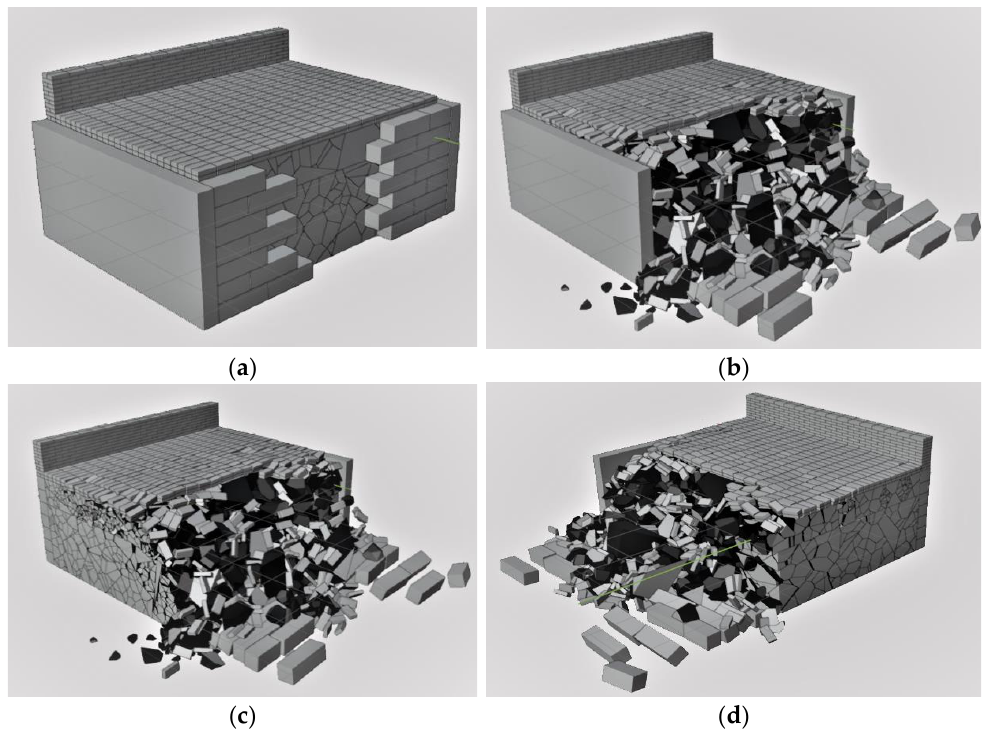
Figure 19. Stone layer collapse in a flat section: ( a ) Initial; ( b ) Final; ( c ) Final without left retaining wall; ( d ) Final without right retaining.